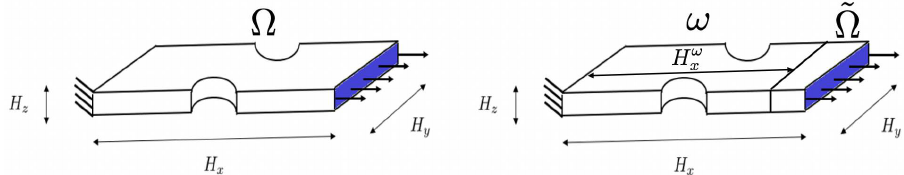
Fig. 6. Computational domain Ω (left) and its partition Ω = ˜Ω ∪ ω (right).